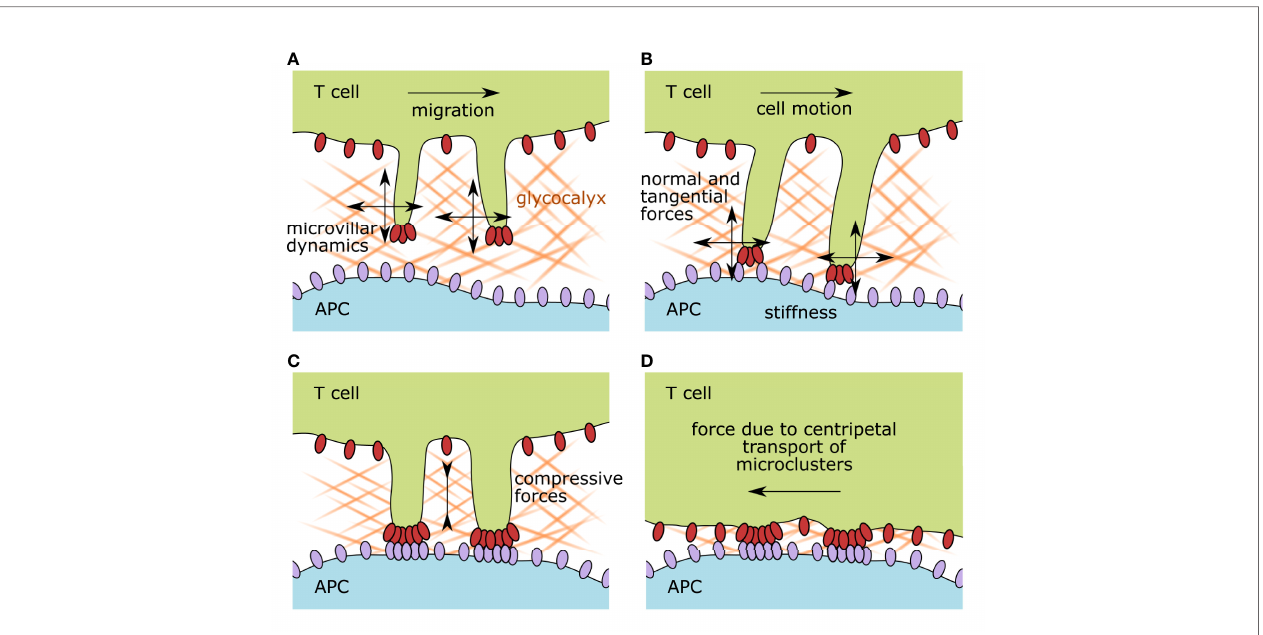
FIGURE 1 | Illustration of the membrane organization of scanning and activated T cells and the accompanying possible mechanical forces affecting surface receptors. (A) During immune surveillance, T cells scan target cells via microvillar protrusions. The fi rst physical barrier they encounter is the glycocalyx of the target cell. Antigen scanning speed is impacted by the glycocalyx physicochemical properties such as stiffness, density, and matrix composition, but also by the migrational speed of the T cell itself and its microvillar dynamics. (B) As soon as surface receptors on the microvillar tips interact with their ligands on the opposing membrane, the formed bonds experience a force vector with normal and tangential components. The surface stiffness of the target cell and the microvillar elasticity also in fl uence the interacting receptor – ligand pairs. (C) Upon recognition of a cognate antigen, T-cell activation starts. Surface receptor molecules build signaling platforms while the two participating plasma membranes approach each other, compressing the remaining glycocalyx components. (D) After the initiation of TCR signaling, the zonal organization of the immunological synapse is established and signaling foci, called microclusters, are pulled by the actin cytoskeleton toward the center of the cell. This dragging motion is also causing mechanical strain on the involved receptor – ligand pairs. APC, antigen-presenting